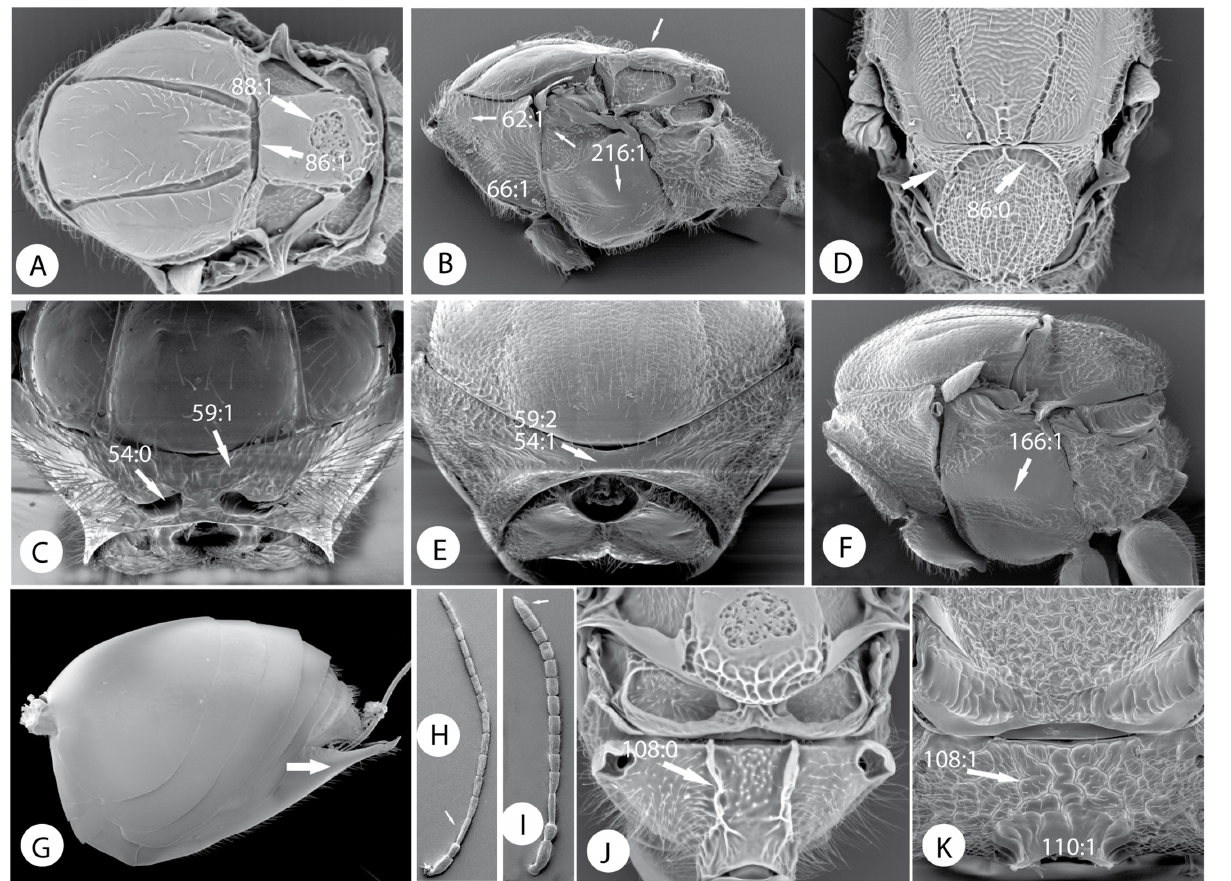
Fig 11. Morphological characters of Pediaspidini, Cynipini and Diplolepidini. A) Pediaspis aceris (Gmelin) bisex. gen., mesosoma in dorsal view. B) mesosoma in lateral view. C) pronotum in anterior view. D) Plagiotrochus razeti Barbotin parth. gen., mesosoma in dorsal view. E) Diplolepis rosae (L.), pronotum in anterior view. F) mesosoma in lateral view. G) Diplolepis rosae (L), metasoma in lateral view. H) Pediaspis aceris , antenna of male. I) antenna of female. J) Pediaspis aceris , propodeum. K) Diplolepis rosae , propodeum.